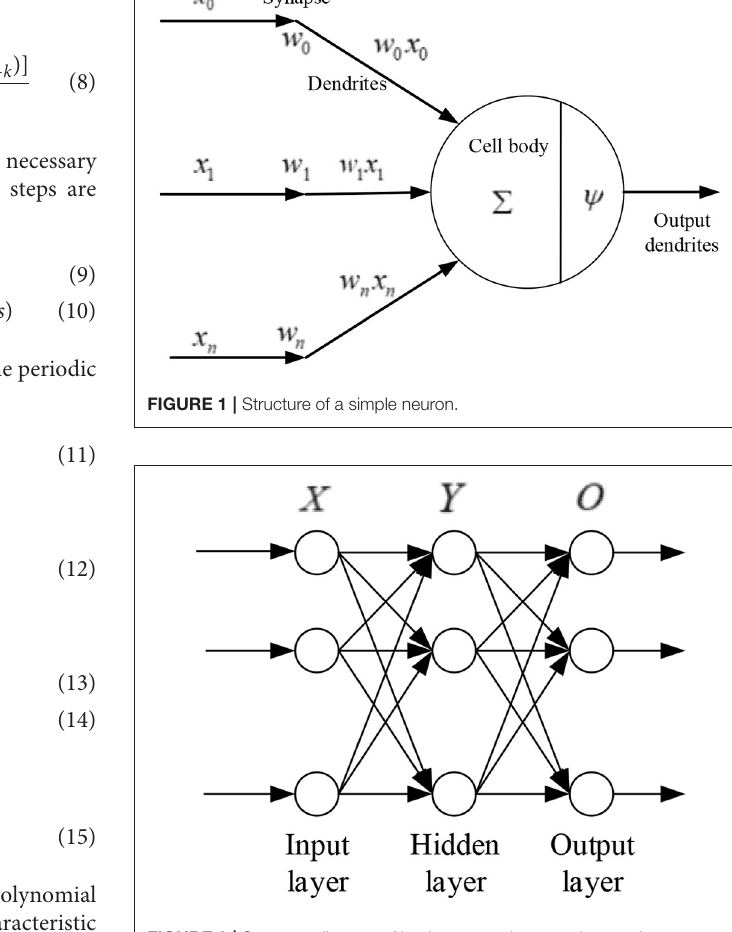
FIGURE 2 | Structure diagram of back propagation neural